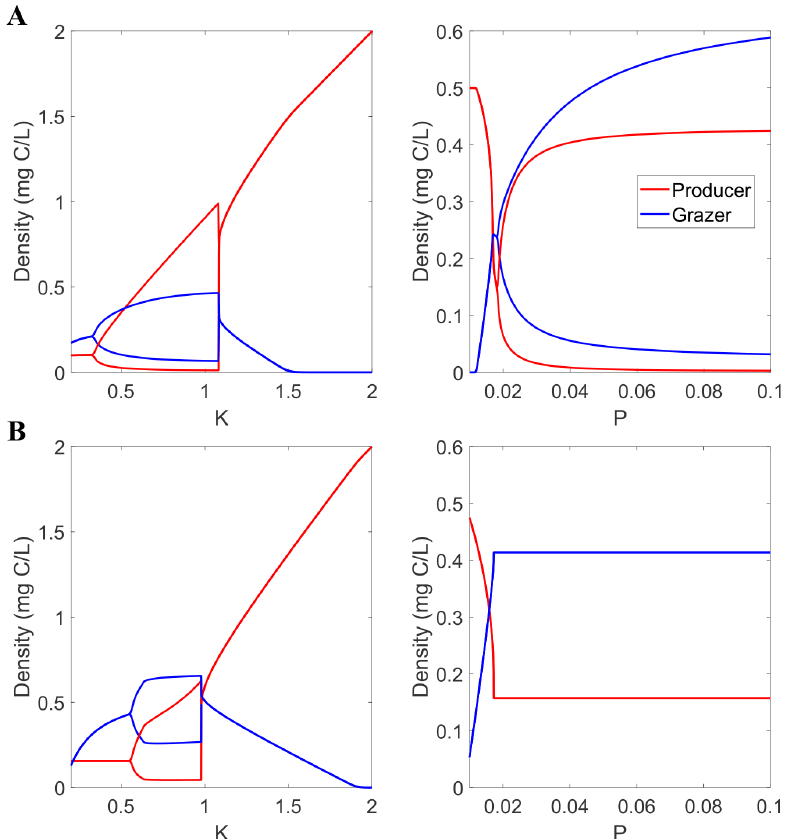
Figure 5. Bifurcations with respect to parameter K and P . ( A ) The MRL model. ( B ) The LKE